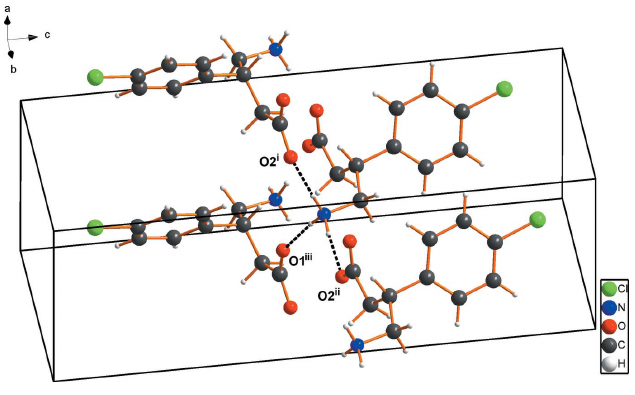
Figure 2 Partial packing diagram of ( R )-baclofen form C